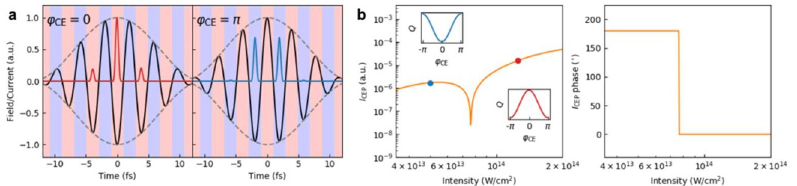
Fig. 2: a. Fowler-Nordheim tunneling emission (red and blue curves) from a cos 2 -shaped model pulse (black curve) with 𝜑 CEP = 0 (left panel) and 𝜑 CEP = 𝜋 (right panel). Even half-cycles are shaded red, and odd blue. Note that here we define 𝜑 CEP = 0 to correspond to a negative peak field. b. The CEP- sensitive current (left) and relative phase (right) for a cos 2 -shaped model pulse with 10 fs